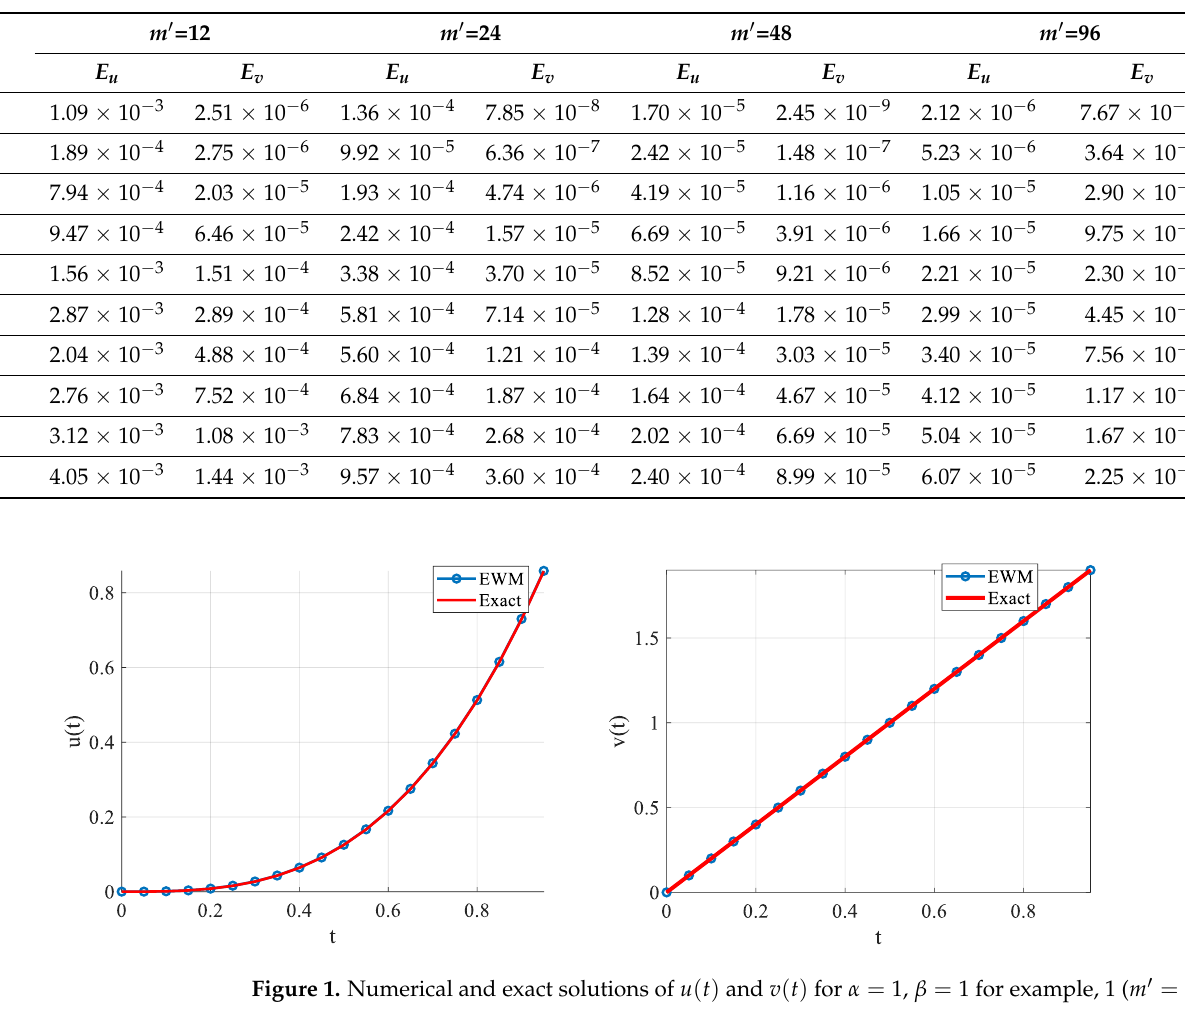
Table 1. Absolute errors E u and E v corresponding to u ( t ) and v ( t ) for several m (cid:48) values of example 1.